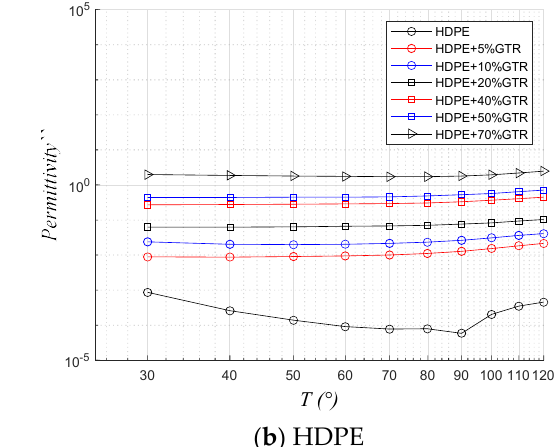
Figure 8. Thermal response of imaginary permittivity ( ԑ ”) with a temperature range of 30 to 100 °C, at 50 Hz, of ( a ) LDPE/GTR compounds and ( b ) HDPE/GTR compounds.